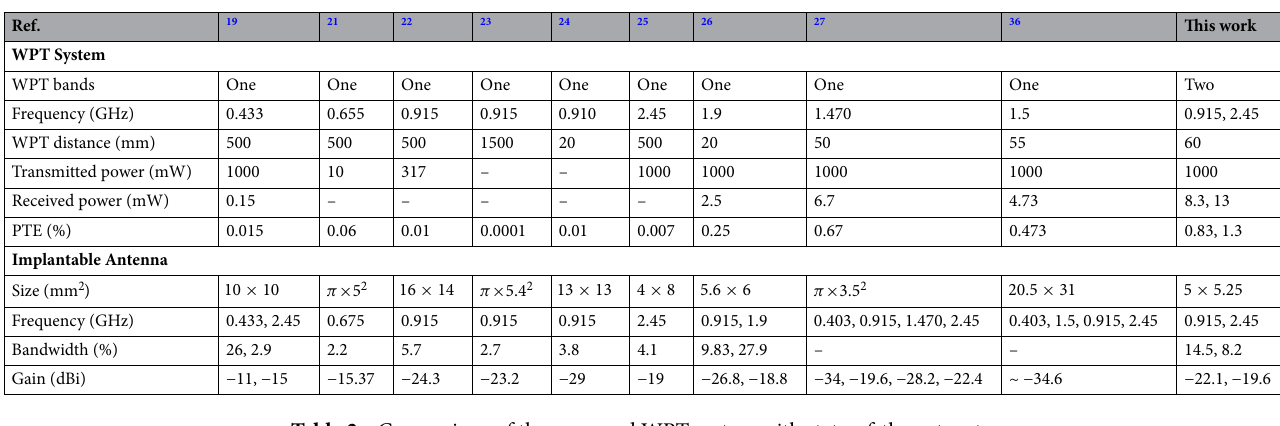
Table 2. Comparison of the proposed WPT system with state-of-the-art systems.